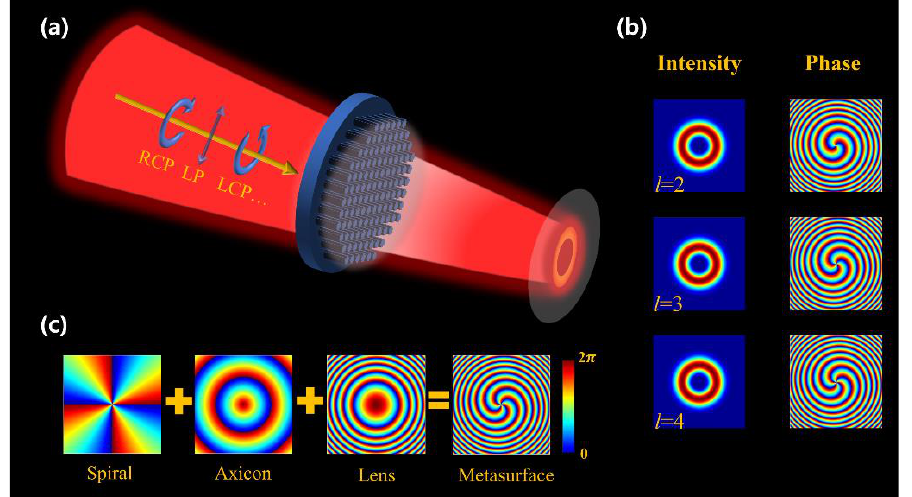
Figure 1. Generation of polarization-independent PVBs. ( a ) Schematic of the polarization- independent metasurface. ( b ) Simulated intensity distribution and phase distribution of PVBs. ( c ) The phase profile of the designed metasurface includes the phase of a spiral phase plate, an axicon, and a Fourier transformation lens.